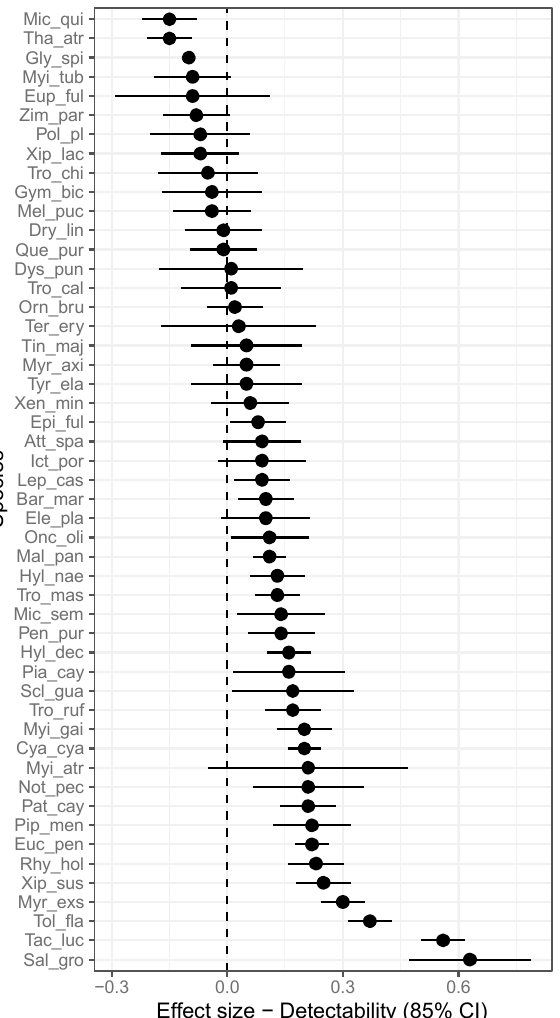
Figure 2. Model-averaged estimates of effect sizes of Era on bird detectability. Error bars are 85% confidence intervals. The dot line represents no change in detectability between Eras; species to the left of the line had higher detectability in the historical era, whereas species to the right of the line had higher detectability in the current era. For more information on species code and names, see Table S1.